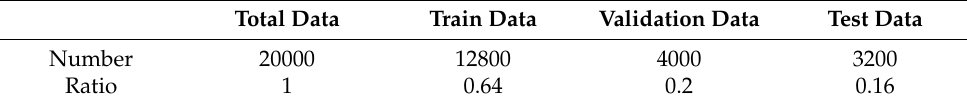
Table 3. Number of data sets used.